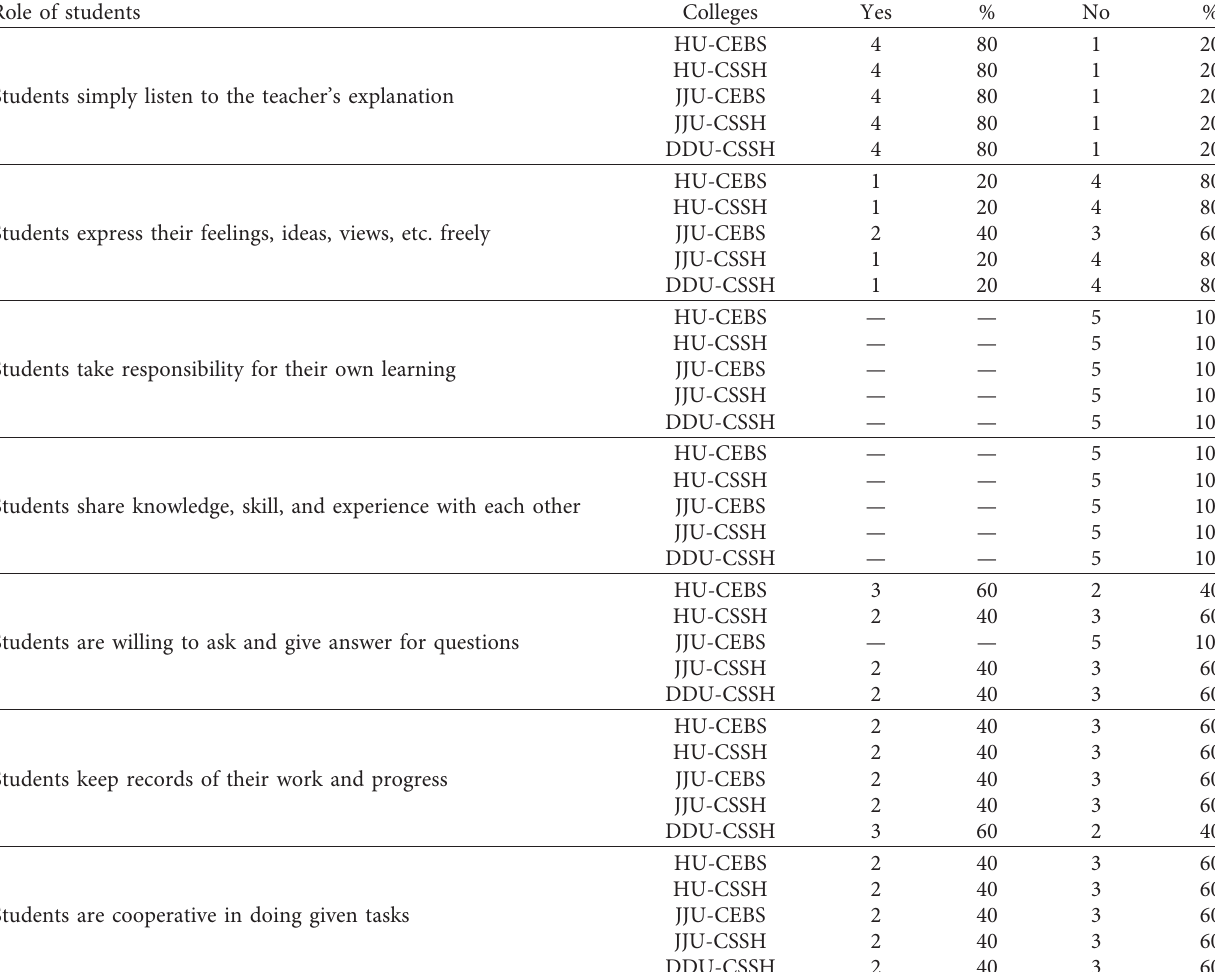
Table 3: Students’ role in classroom